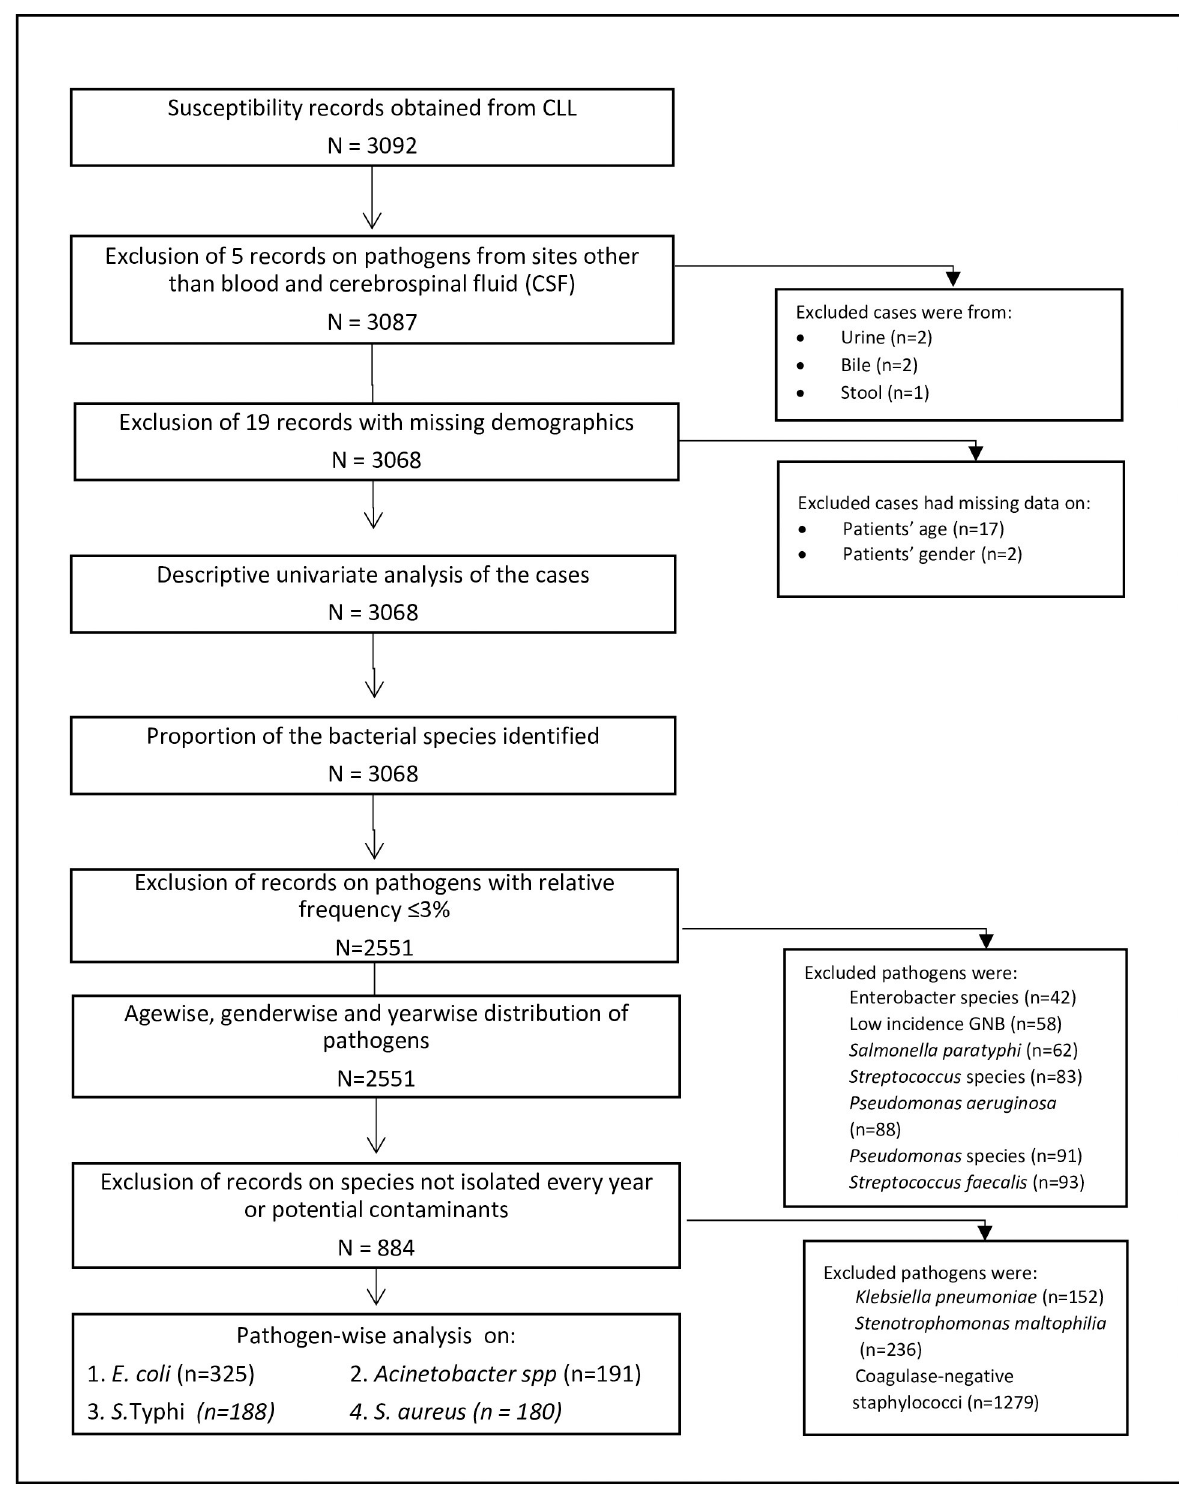
Fig 1. Flow of cases. Flow of the cases through the study has been shown.